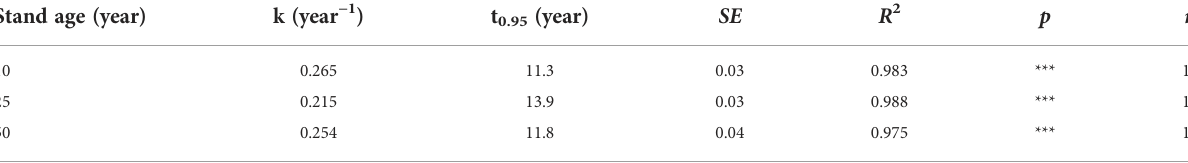
R 2 , coef fi cient of determination; SE, standard error. ***indicates signi fi cance at p< 0.001.